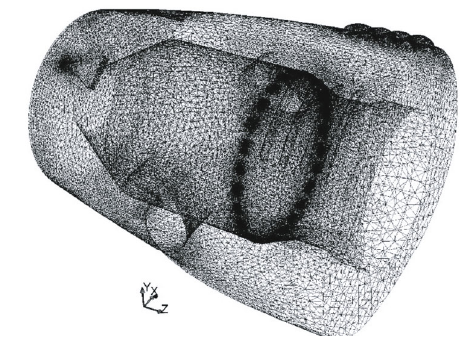
Figure 2: 3D mesh consisting of approx. 1.4 million